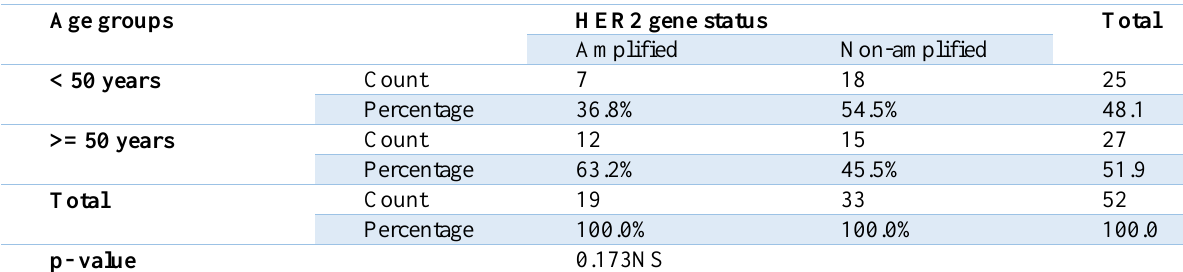
Table. 4. Association between HER2 Gene Status by Silver DNA in Situ Hybridization and Hormone Receptors Immunoreactivity Hormone receptor